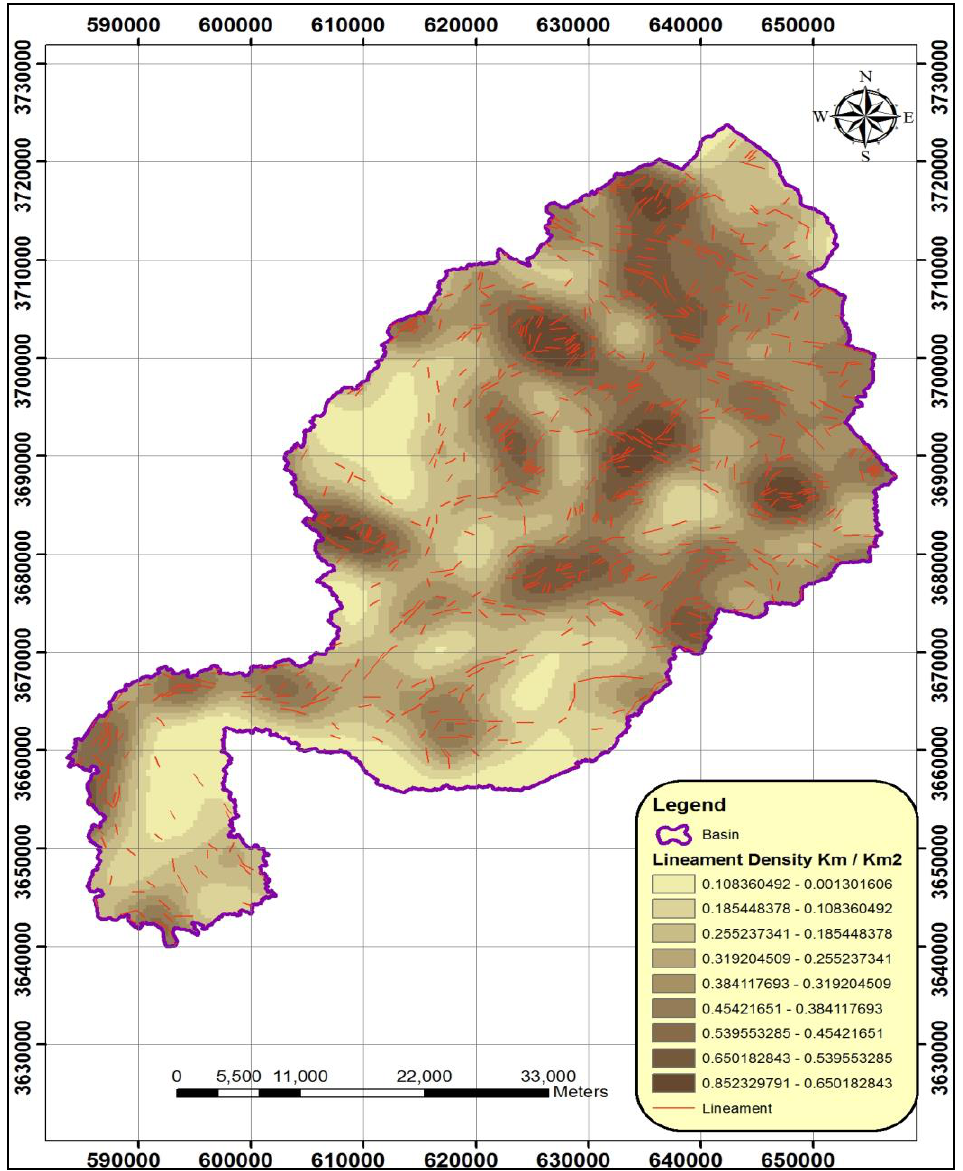
Fig. 4: The lineament density map by using Arc